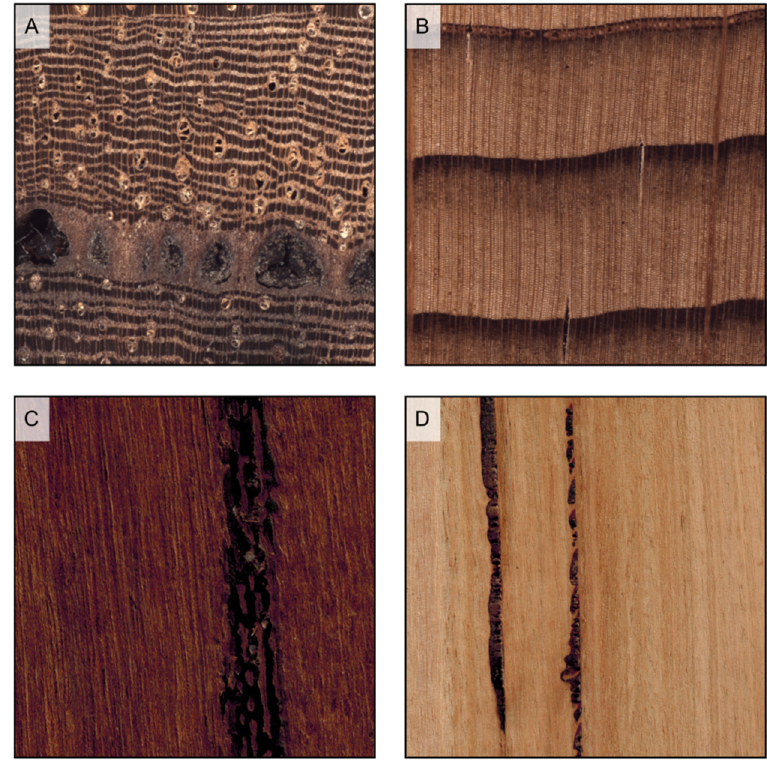
Figure 19. Traumatic canals as they appear on the transverse section of Scleronema micranthum ( A ) and Cedrus atlantica ( B ), and on the longitudinal section of Cariniana micrantha ( C ) and Eucalyptus obliqua ( D ).